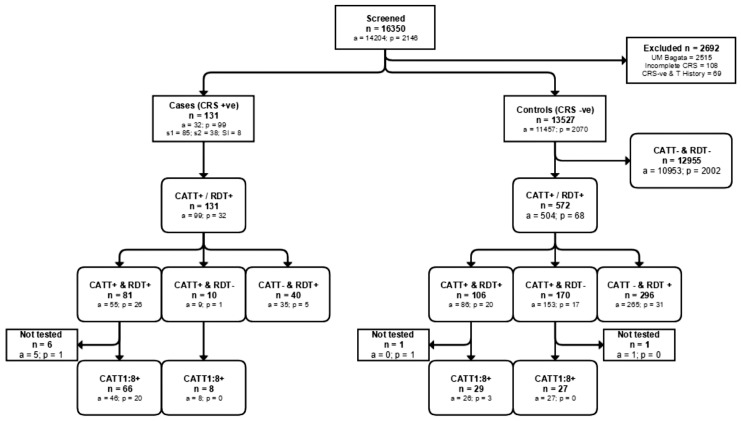
Flow diagram of participant enrolment.Note that for illustrative purposes in this flow diagram, if either reader recorded a positive result then it is recorded as positive in this Figure.